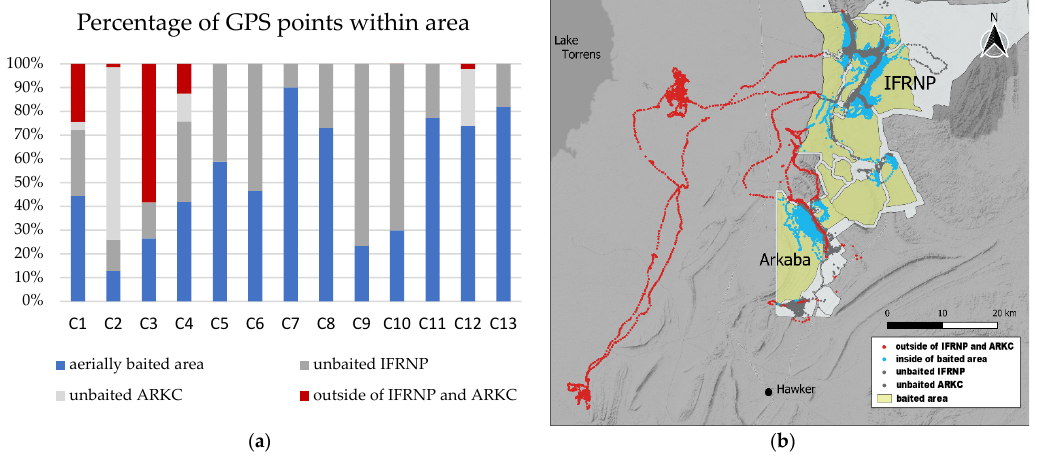
Figure 3. ( a ) Proportions of GPS points of the collared feral cats that fell within the aerially baited zone, the Ikara-Flinders Ranges National Park (IFRNP), Arkaba Conservancy (ARKC) or outside of the National Park and Arkaba; ( b ) GPS points of the feral cats that were collared in 2020 falling outside (red) of the conservation areas IFRNP and Arkaba and within (grey). GPS points that were in the aerially Eradicat ® -baited area are marked in blue. The National Park and Arkaba are highlighted in white. Base image: Stamen/QGIS [37] . Map created using the Free and Open Source QGIS. The cat collared at AR (AC1) was a 2.6 kg male in average condition (as determined